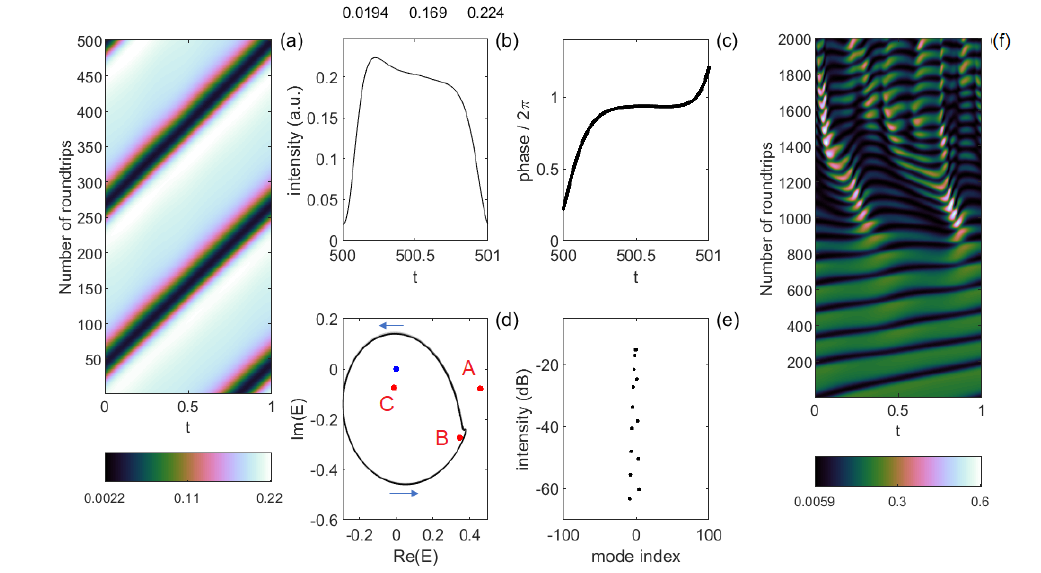
Figure 7. ( a – e ) Same as Figure 2 but with b = 5. ( f ) Evolution of the field intensity when we take as initial condition the stable phase soliton with b = 5 and set b = 4. The phase soliton evolves into a complex spatio temporal